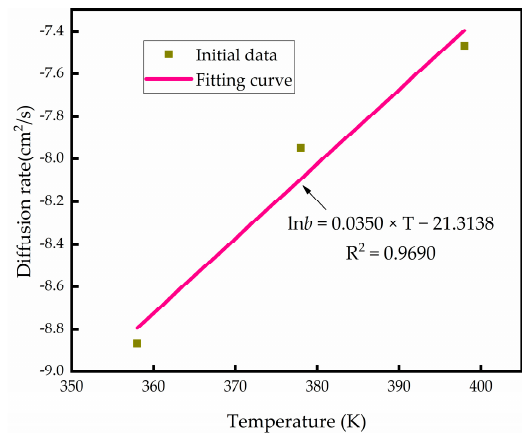
Figure 5. Linear fitting curve of T and ln b.